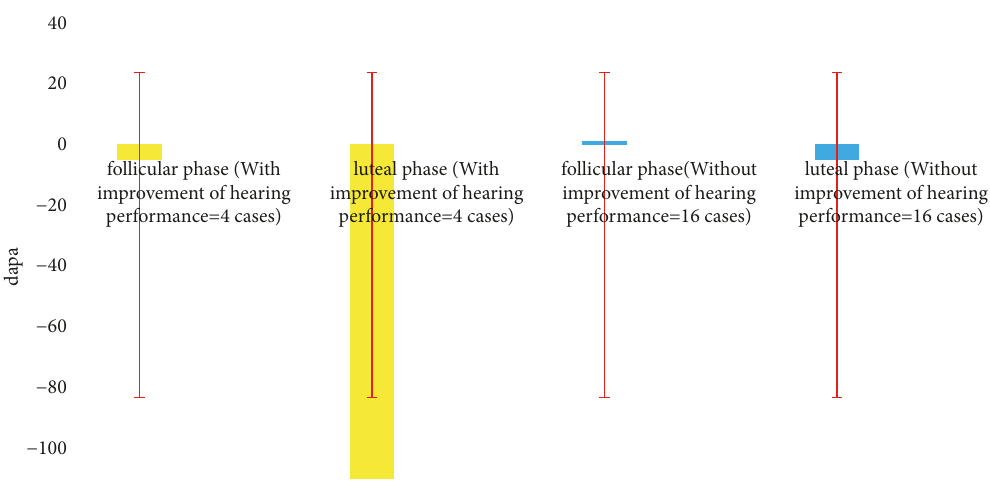
Figure 3: Mean middle ear pressure of twenty healthy female in follicular-luteal